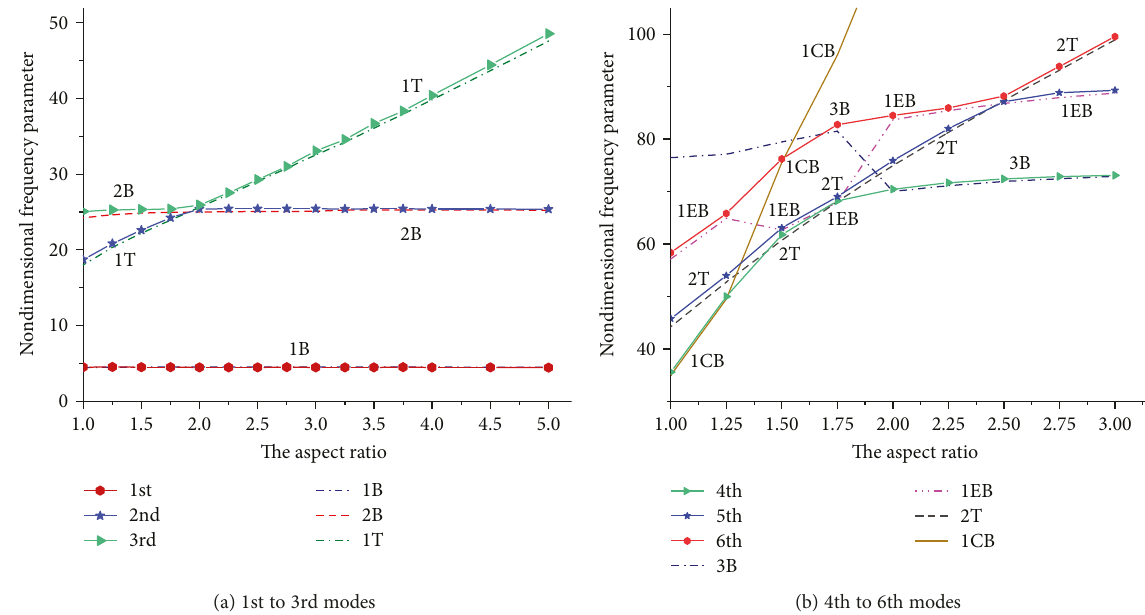
Figure 8: Variations of nondimensional frequency parameters with the aspect ratio ( h = 20 , n = 2 , h